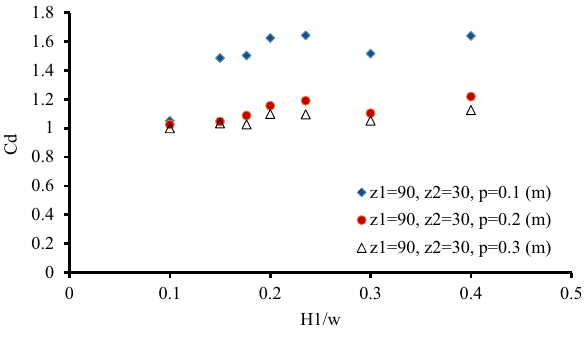
z 1 = 90°, 2 = 30° and various weir